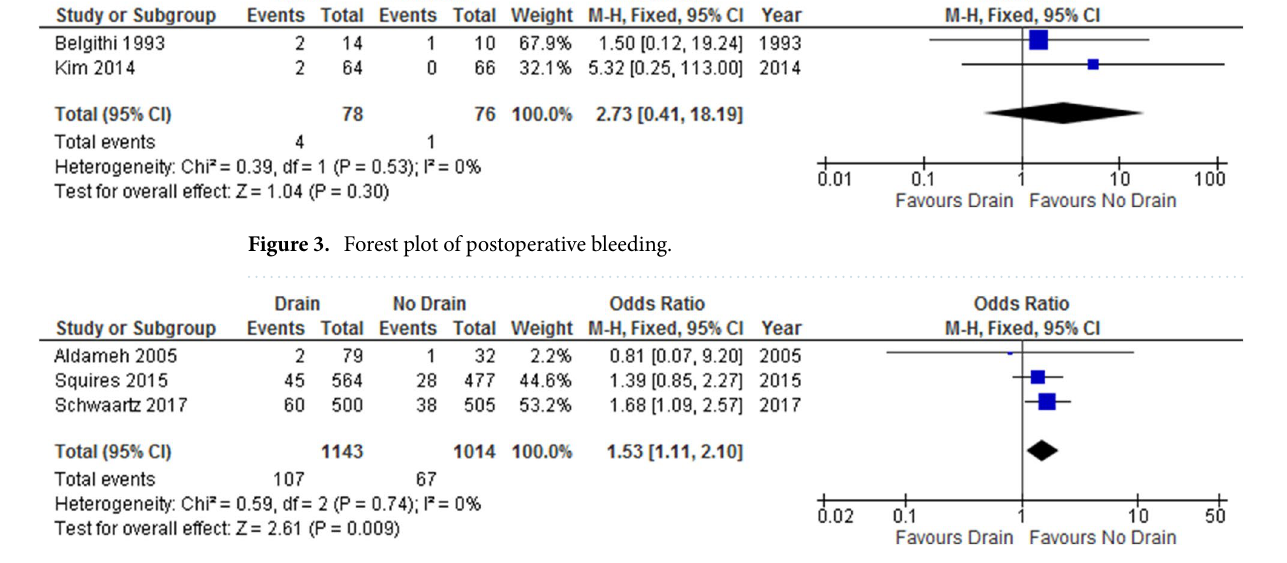
Figure 4. Forest plot of postoperative interventional percutaneous drain.